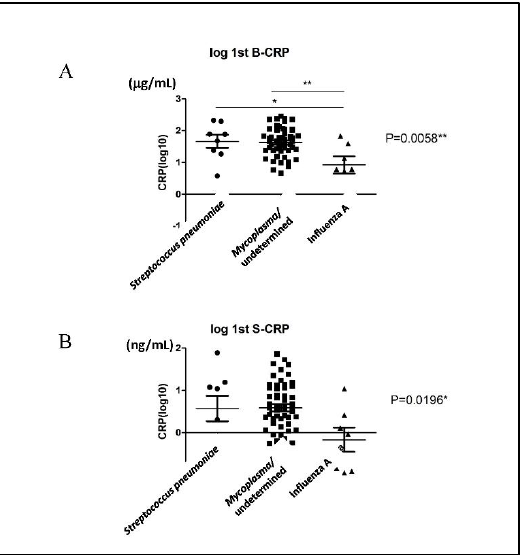
Figure 2. The ( A ) serum and ( B ) salivary CRP levels in Streptococcus pneumoniae , Mycoplasma pneumoniae/undetermined, and influenza A virus groups . * p < 0.05; ** p < 0.01